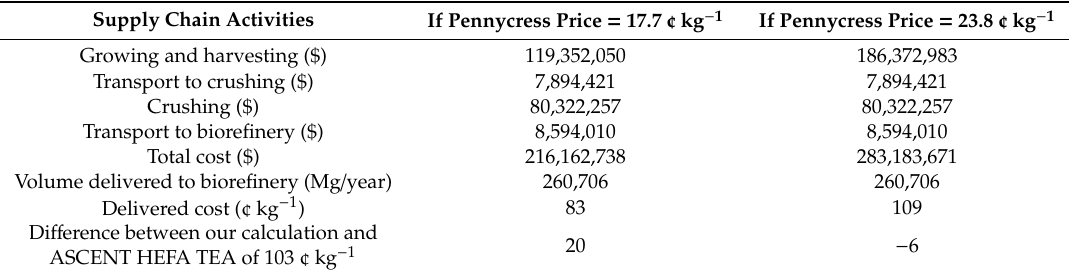
Figure 5. Location of potential crushing facilities in Tennessee estimated by BioFLAME assuming minimum feedstock cost and a maximum one-way driving distance of 112.65 km. Table 7. Estimated supply chain costs from field to biorefinery.